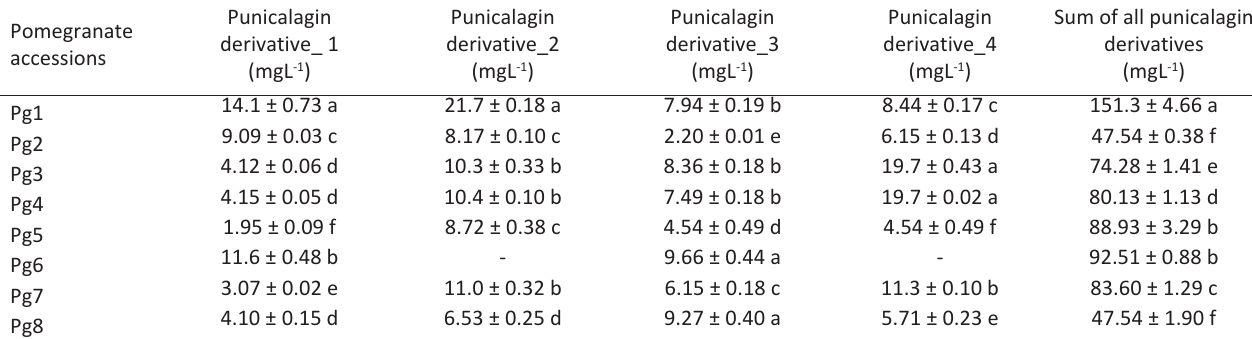
The sum of all punicalagin derivatives include also punicalagin α and β. Values are the mean ± SD (n =3). Values followed by the different letter in the same column are statistically different according to Tukey’s